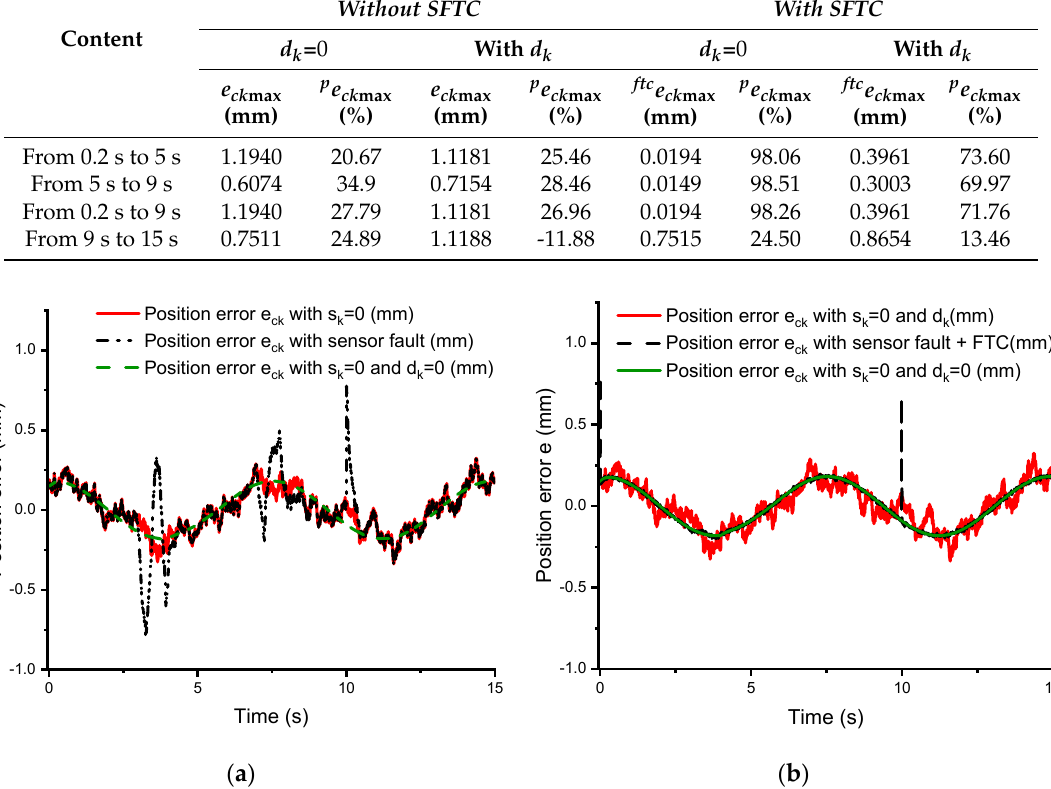
e with disturbance ck